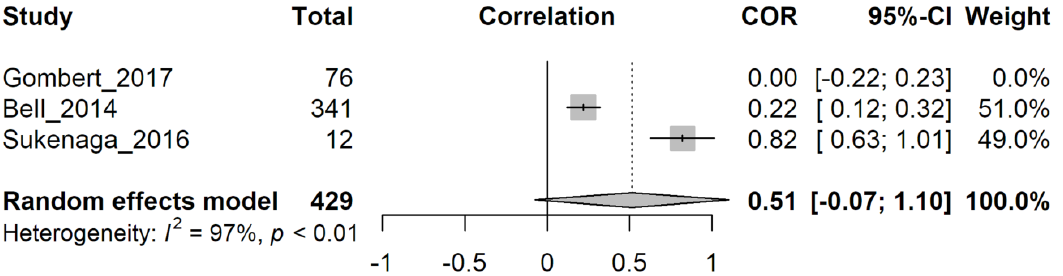
Figure 6. Random effect model analysis of group 2’s papers excluding Gombert (2017). Study: the first author followed by the year of the study examined. Total: total number of subjects in each group. COR: correlation (extracted from the study) between pain sensations and methylation levels with confidence intervals (grey squares). A 95%-CI: confidence interval for 95% on COR. Weight: statistical “weight” for each study. In bold characters, results from random effect model analysis are indicated as a graphical diamond on the correlation graph. Heterogeneity: results from heterogeneity test, I 2 , describes the percentage of variation across studies that is due to heterogeneity rather than chance, p : p -value derived from Cochran’s Q